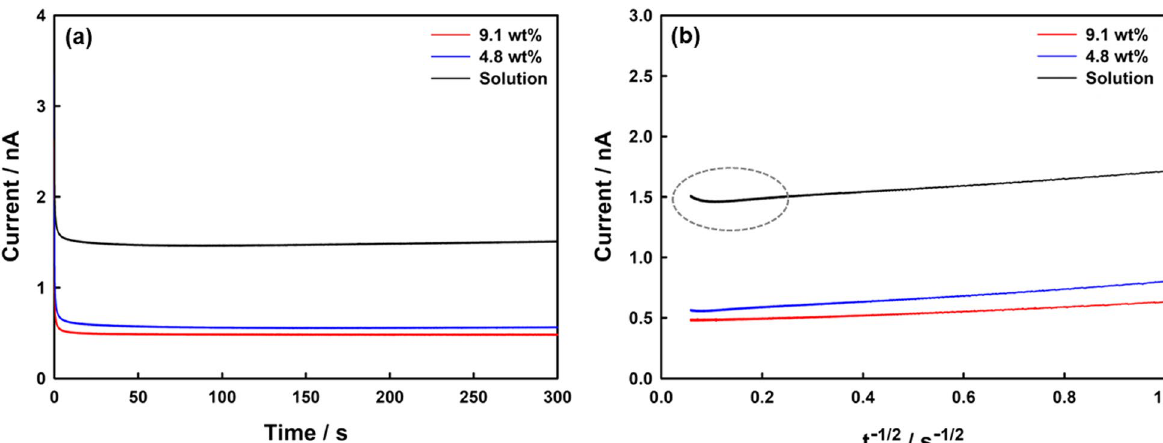
Fig. 5 a CA curves of 0.5 mM Fe(CN) 64– and 0.1 M KCl in various agarose hydrogel concentrations (colored lines) and in solution (black line) at 0.3 V, which is applied to an Au UME. b Plots of current as a function of t –1/2 of ( a ). The gray dotted circle showed the current fluctuations due to the natural